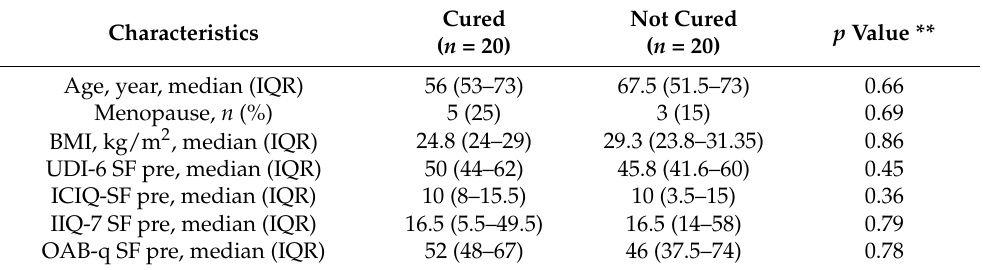
Table 6. Univariable analyses of variables potentially involved in the risk of FMS failure for OAB.